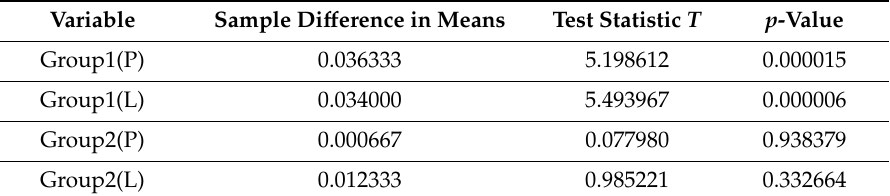
Table 5. Student’s t -test for means of dependent samples.